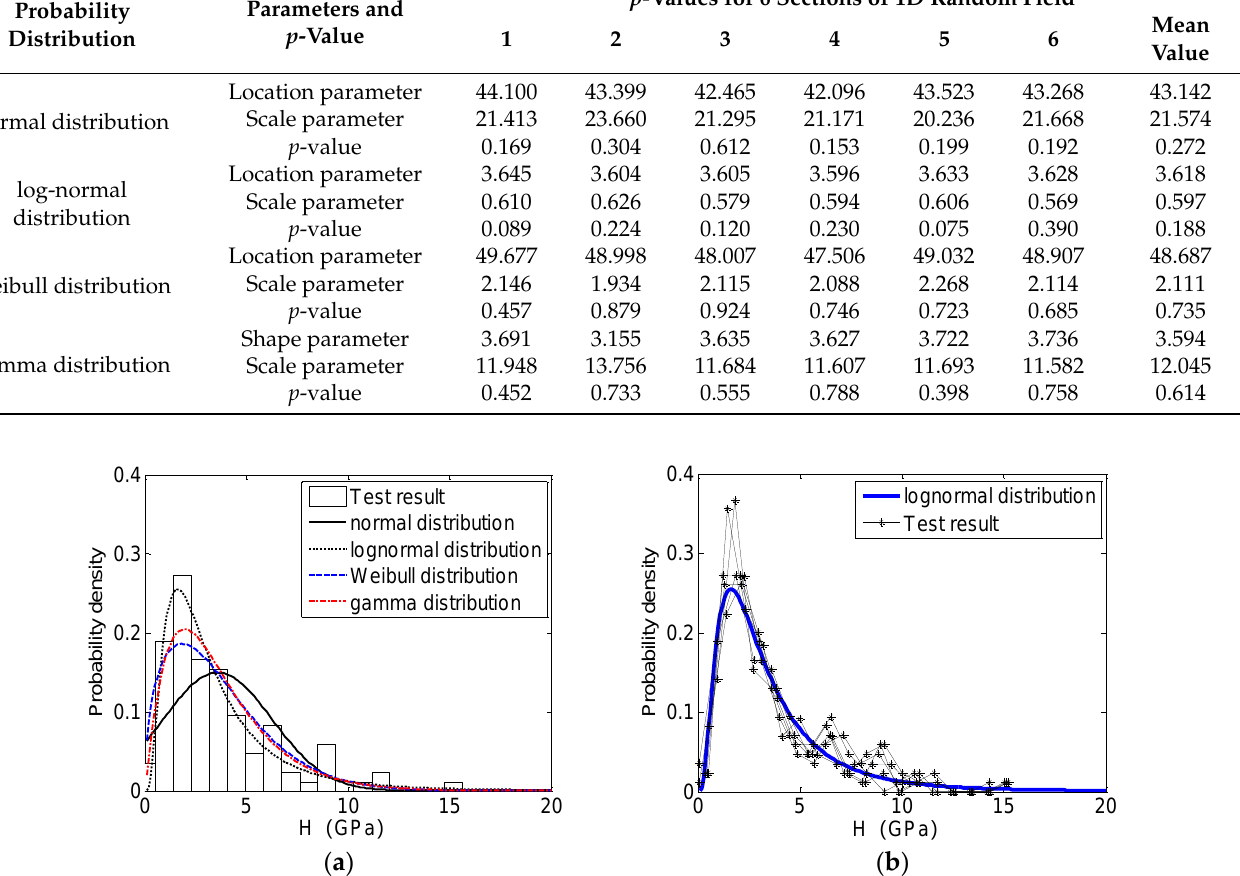
Table 4. Pointwise parameters estimation for the nano-modulus of the ITZ.